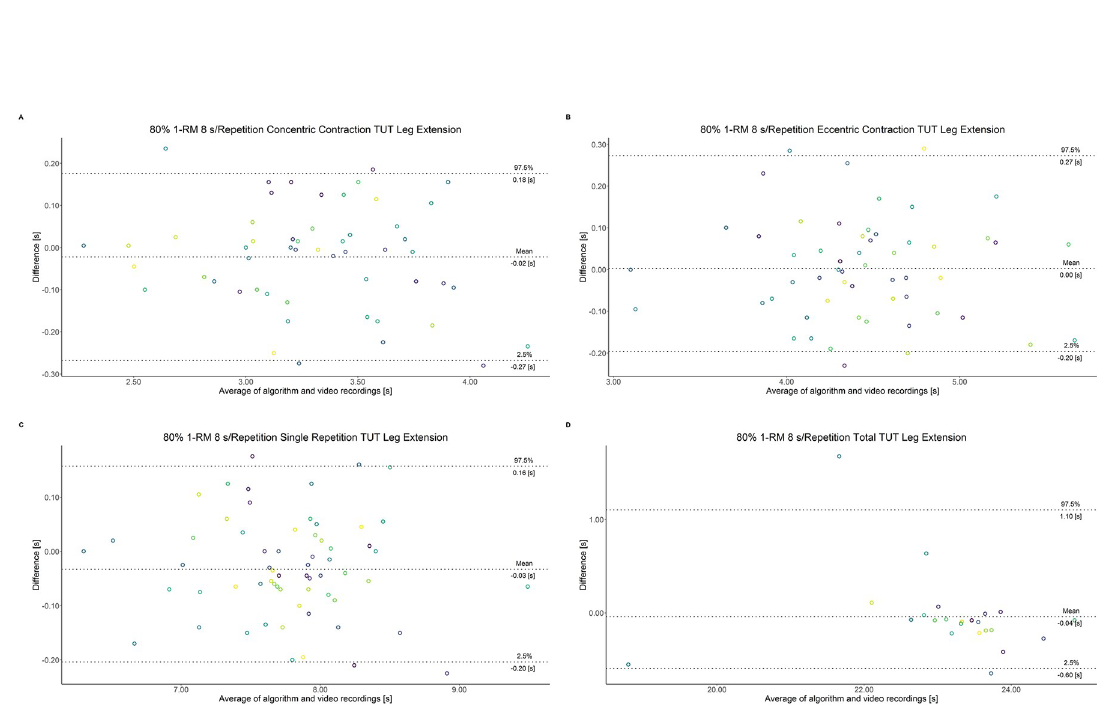
Fig 14. Bland-Altman plots of agreement between algorithmically accelerometer derived and video recordings derived contraction-specific phases of the leg extension machine at 80% 1-RM with a velocity of 8 s per repetition. A: Concentric contraction phase. B: Eccentric contraction phase. C: Single repetition. D: Total time-under-tension.